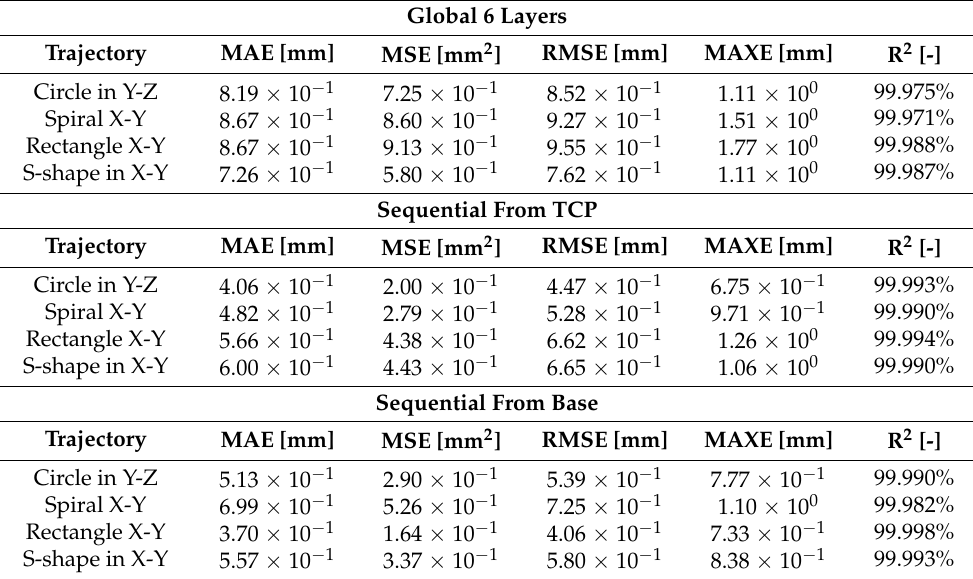
Table 9. Global IK—Sequential IK procedure trajectory errors in the laboratory